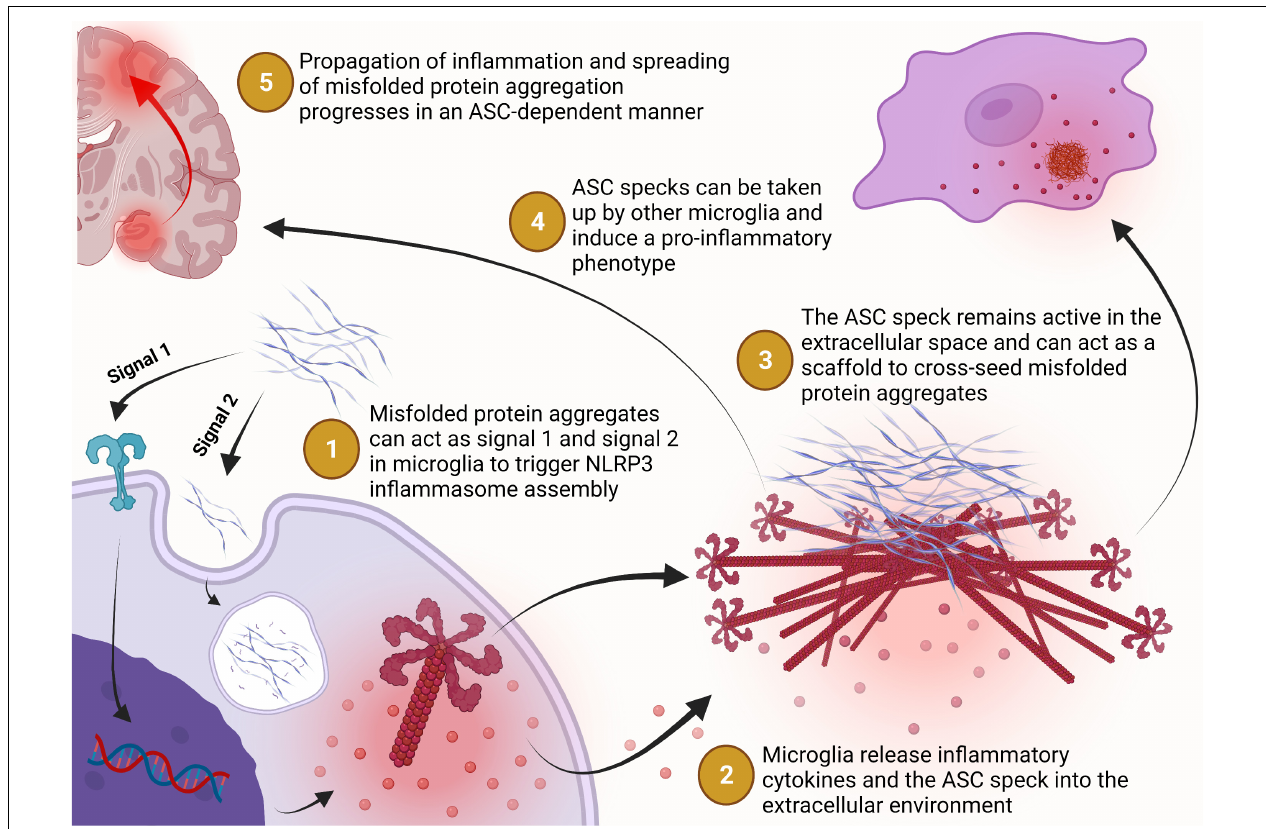
FIGURE 4 | Misfolded protein aggregates bind to toll-like or scavenger receptors which triggers the expression of NLRP3 and caspase-1 to prime the cell for inflammasome assembly in a MyD88-NF κ B signaling dependent manner. Extracellular misfolded protein aggregates may be internalized by the phagolysosomal pathway but can escape lysosomal degradation and trigger assembly of the NLRP3 inflammasome (step 1). The NLRP3 inflammasome catalyzes the maturation of interleukin-1 β and interleukin-18 which can be transported extracellularly or released into the extracellular environment during pyroptosis for inflammatory signaling (step 2). Assembly of the NLRP3 inflammasome may progress to the formation of the ASC speck, a supramolecular complex with enhanced inflammatory signaling capacity, which may then be released into the extracellular environment following pyroptosis or some other non-pyroptic mechanism (step 2). Once in the extracellular space, the ASC speck remains functionally active for inflammatory cytokine maturation, pro-aggregatory modifications of other proteins, and cross-seeding of neuronally derived misfolded protein aggregation (step 3). The ASC speck can also propagate inflammation from one microglial cell to another by inducing a pro- inflammatory phenotype in cells that phagocytose the ASC speck but fail to degrade it (step 4). Together, these activities of the ASC speck implicate its role in the propagation of inflammation and spreading of protein aggregation in a vicious cycle that contributes to the chronic progressive nature of Alzheimer’s disease and Parkinson’s disease (step